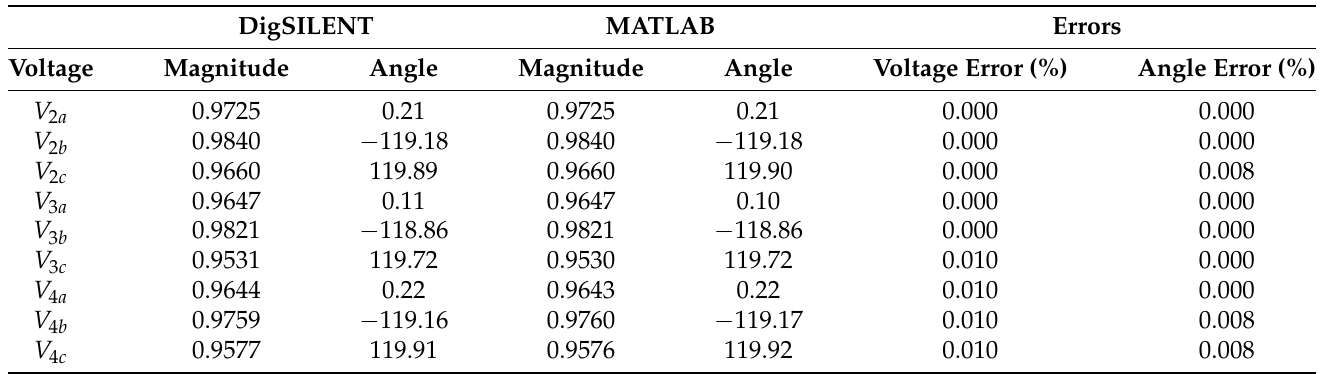
Table 3. Voltages in the small test example with pure Y -connected loads (all values in pu).